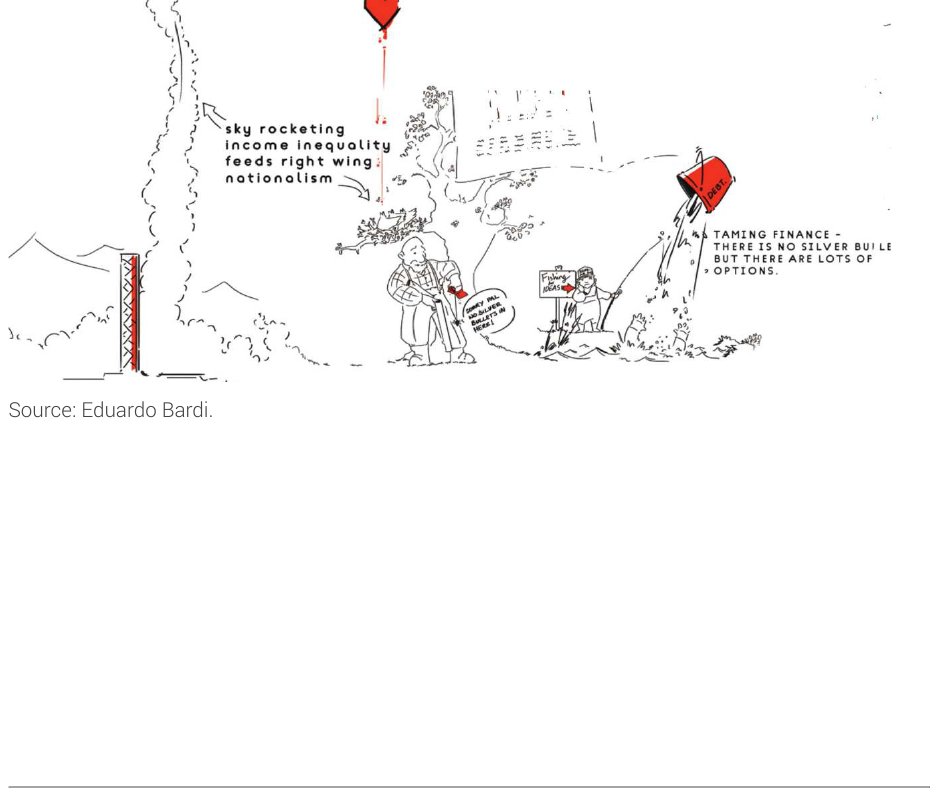
Figure 3. Lived Experience of Austerity